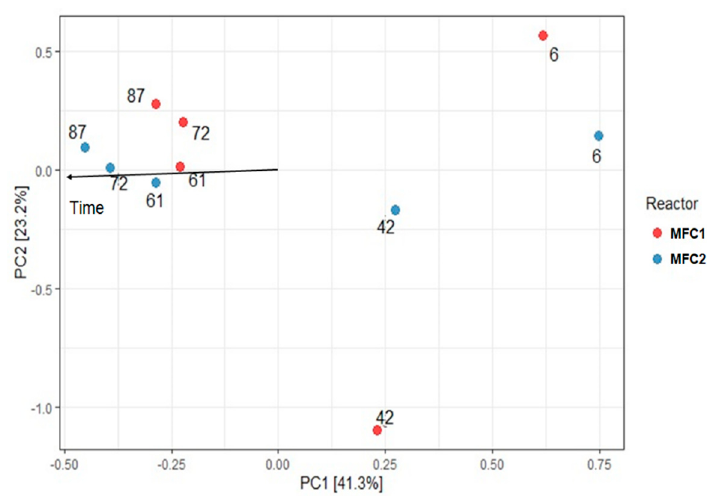
Figure 4. Results of PCA; numbers next to points indicate days of sampling during the MFC operation.